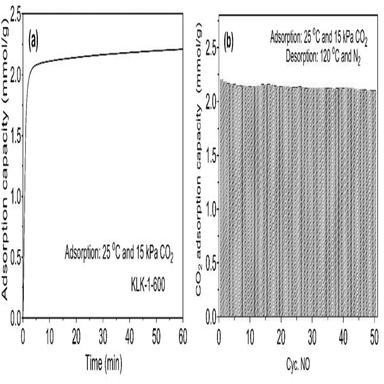
Dynamic CO2 adsorption curve (a) and cyclic adsorption/desorption performance (b) of KLK-1–600 under simulated flue gas conditions containing 15% CO2 in N2. Adsorption temperature: 25 ◦C; Desorption temperature: 120 ◦C.